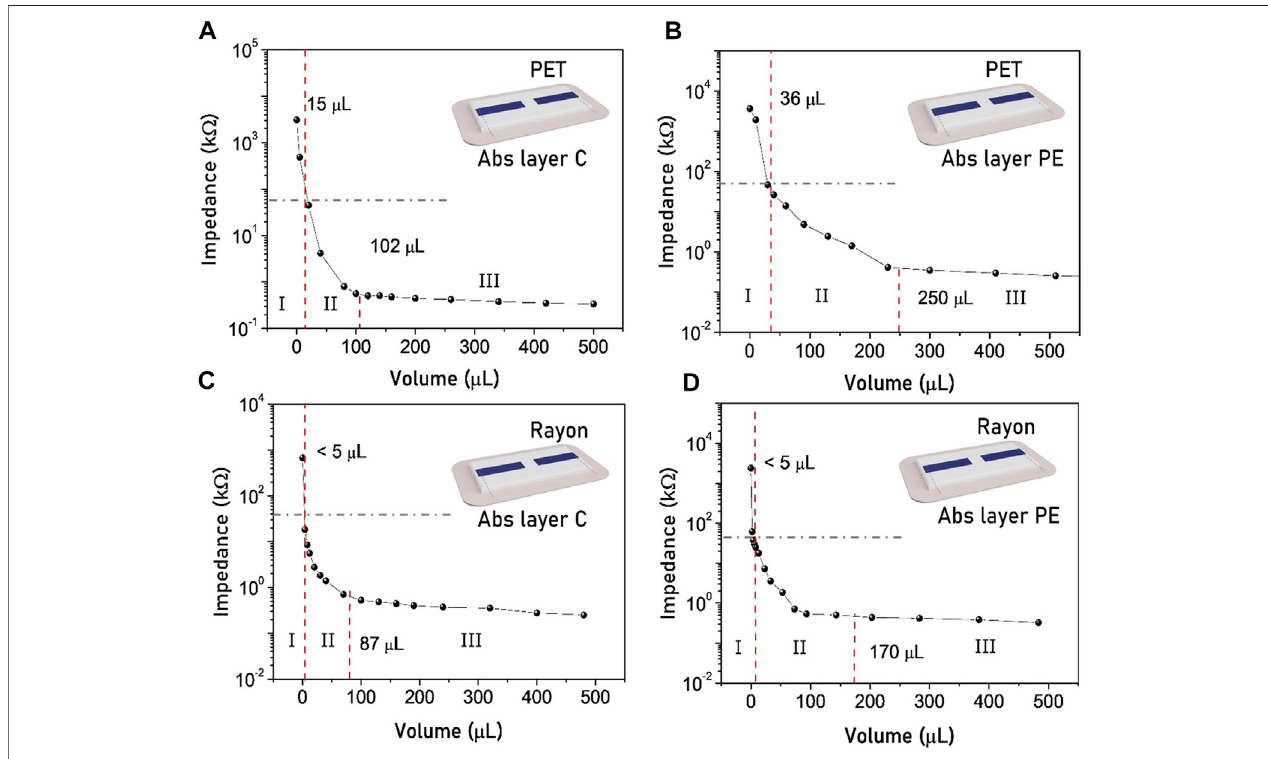
FIGURE4| Bandagesensorresponsetotheadditionofsyntheticexudateusingthecon fi guration witha2 mm distancebetweentheelectrodes. Thedashed lines identifythethresholdandthesaturationvolumesanddemarcatethethreeregimes.ThesensorsbasedongauzePET (A – B) showahigherthresholdvolumethantheone based on gauze Rayon (C – D) .